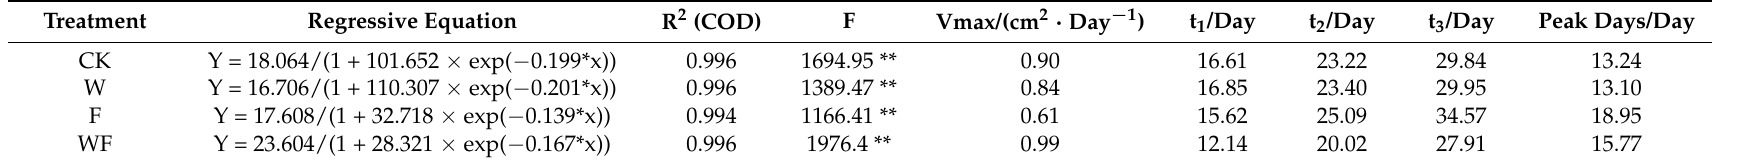
Table 6. Leaf area logistic growth model and characteristic value of the Eucalyptus leaf growth